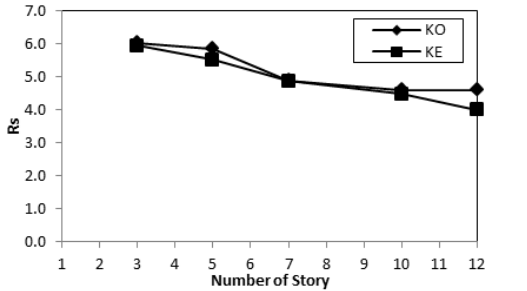
Fig. 12. Number of story-overstrength factor.